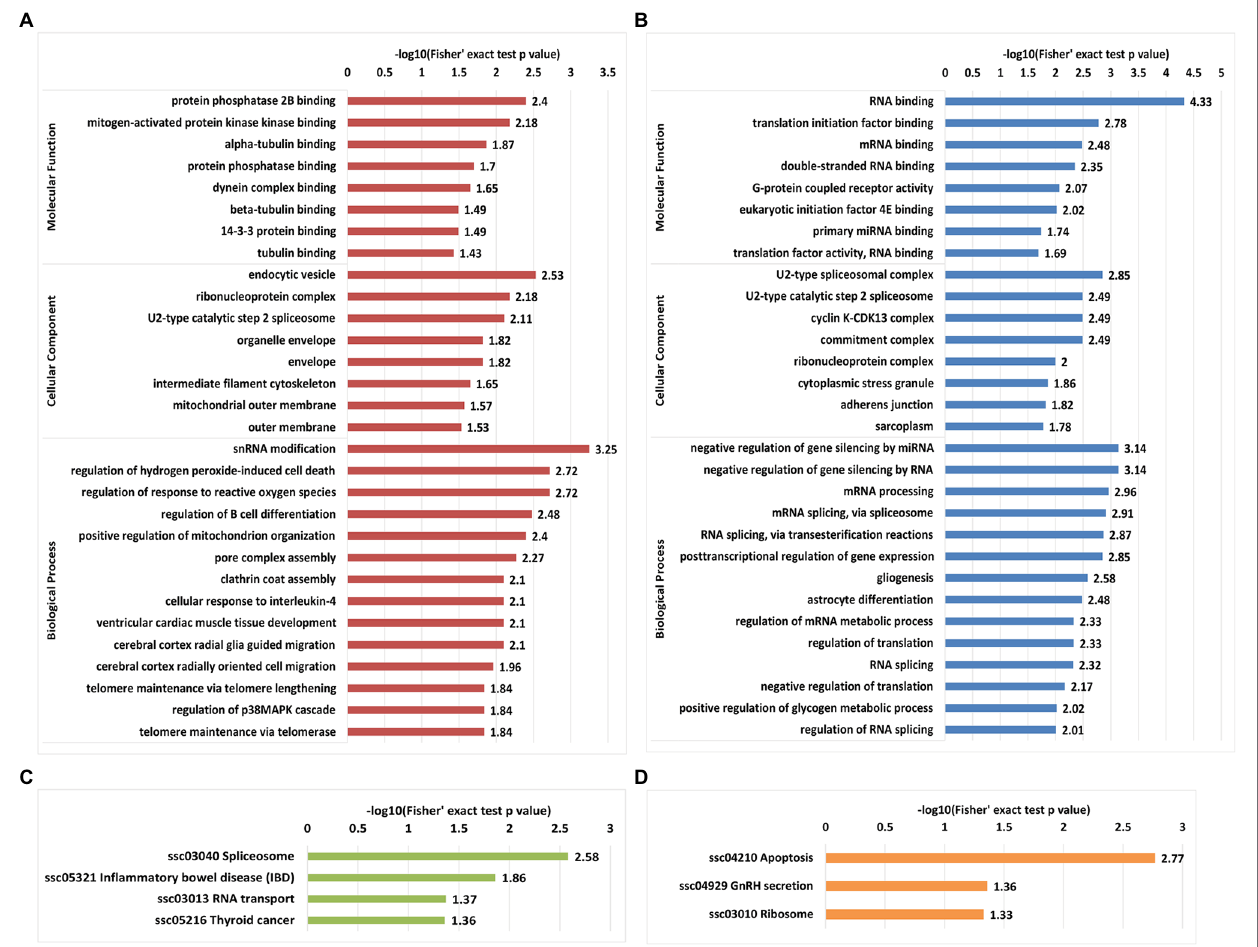
FIGURE 5 | Gene Ontology functional enrichment and Kyoto Encyclopedia of Genes and Genomes (KEGG) pathways enrichment analyses of proteins with differentially regulated phosphosites. (A) GO-based enrichment analysis of proteins with upregulated phosphosites. (B) GO-based enrichment analysis of proteins with downregulated phosphosites. (C) KEGG pathway enrichment analysis of proteins with upregulated phosphosite. (D) KEGG pathway enrichment analysis of proteins with downregulated